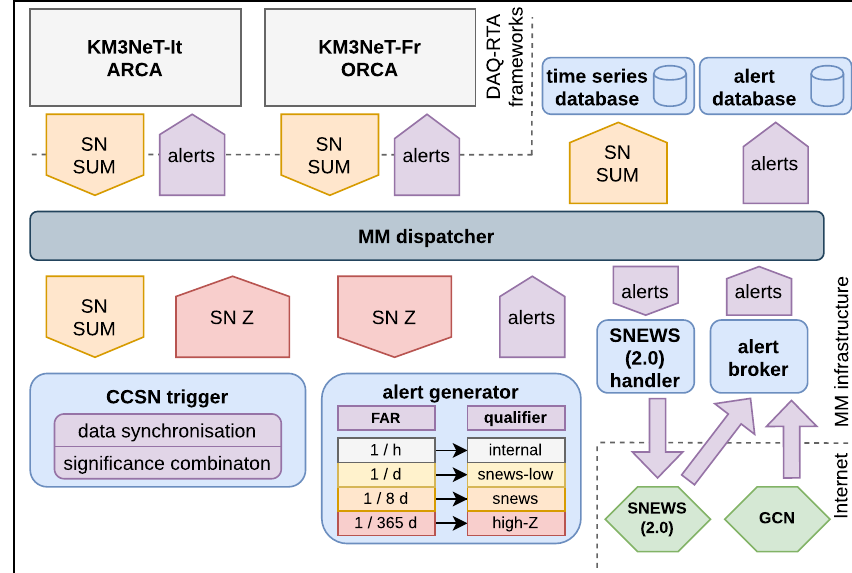
Fig. 4 Overview of the CCSN alert generation and management data flow in the KM3NeT real-time